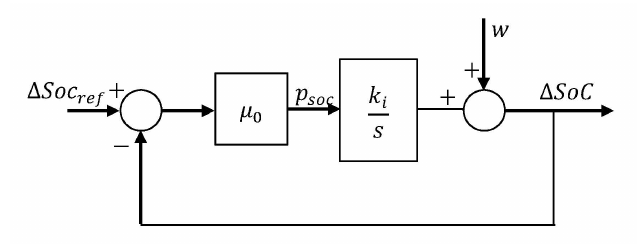
Figure 6. Block diagram of the SoC control scheme.